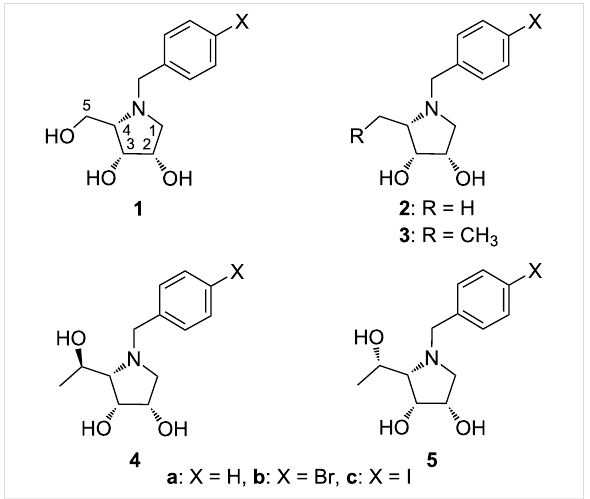
Figure 1: Structures of GMIIb